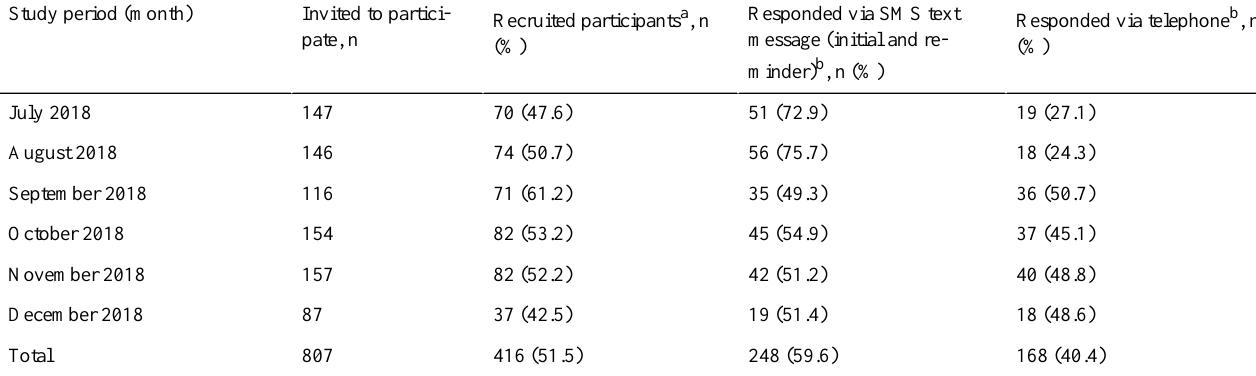
Table 3. Recruitment and response rates by response method, grouped by study period.